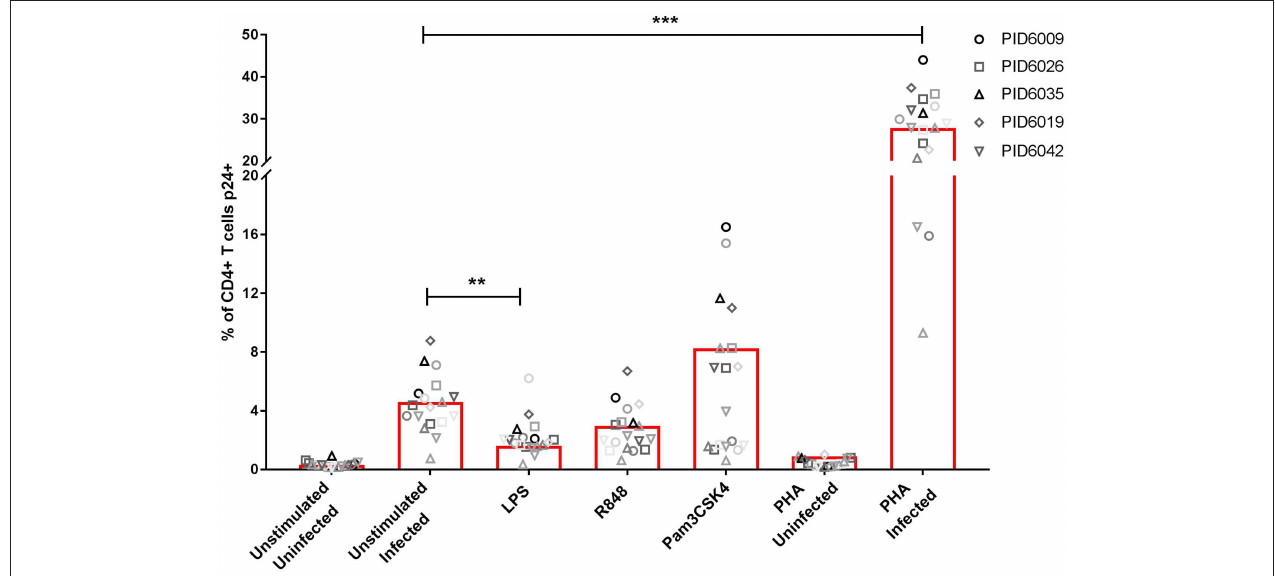
FIGURE 7 | Infection rates (measured by p24 expression) of CD4 + T cells either unstimulated or stimulated with PHA or TLR agonists; LPS (TLR4), Pam3CSK4 (TLR1/2) or R848 (TLR7/8). Each symbol represents a donor, while different shades of each symbol represent repeats for that donor. PHA was used at a final concentration of 10 µ g/ml. TLR agonists were used at a final concentration of 2 µ g/ml. Significance was assessed by two-way ANOVA with Dunnett’s multiple comparisons test. Significance is displayed as ** p < 0.01, *** p < 0.0001 compared to the unstimulated infected control. Sample size, n = 5, 4 donors run in quadruplicate, 1 donor run in